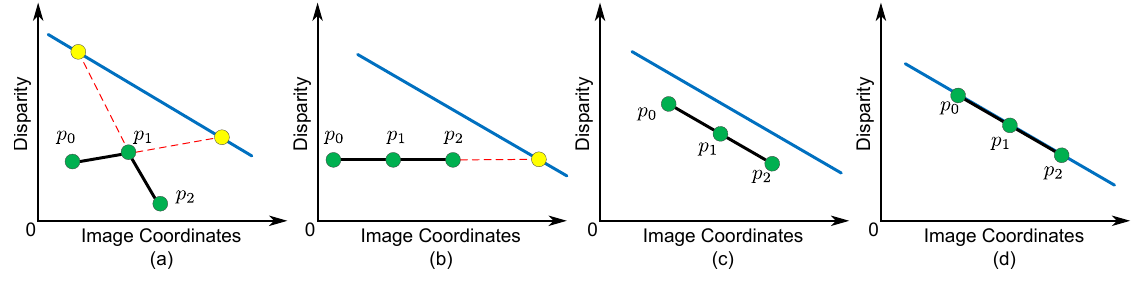
Figure 5. Smoothness term for pixels in the same stable segment ( s spatial similarity weight as the triple-clique Φ 1 assignments. Given Ψ